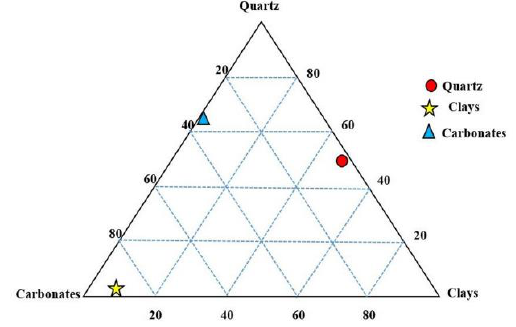
Figure 12: Ternary diagram showing the mineralogical distribution of quartz, carbonates, and clays of Laki Formation